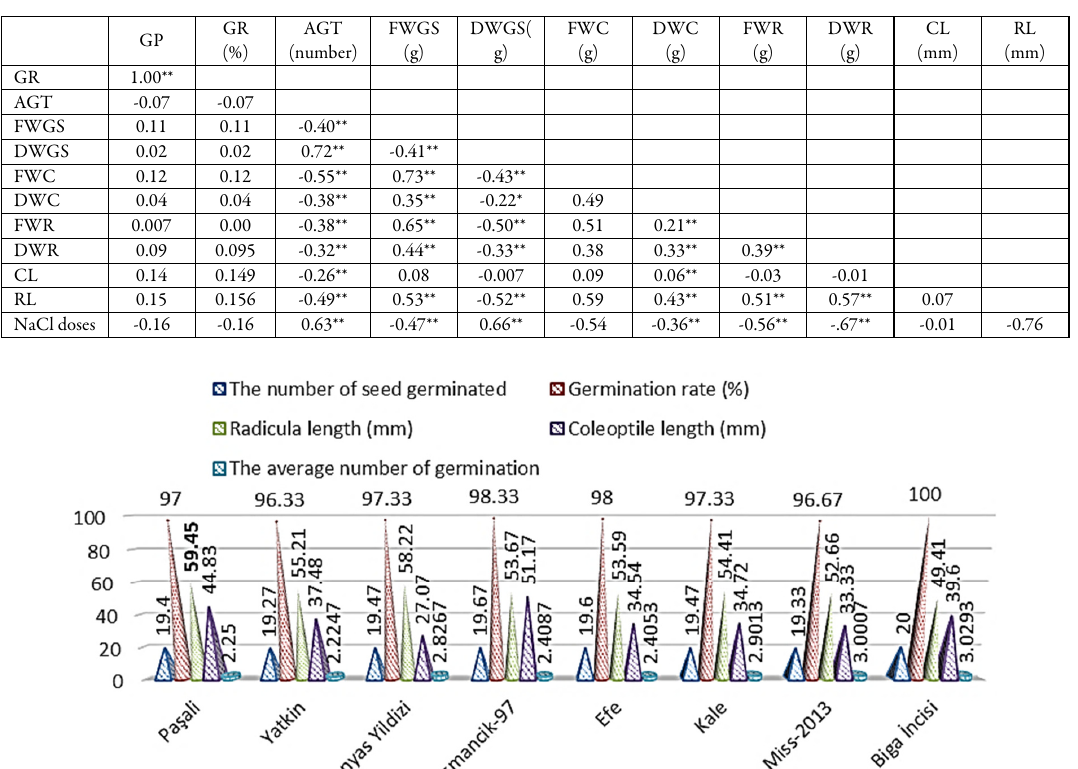
Table 1. Correlation table on average o number of seed germinated (number), germination rate (%), average germination time (day), fresh and dry weight of coleoptile (g), fresh and dry weight of the radicle (g) between each other and salinity concentrations (NaCl)